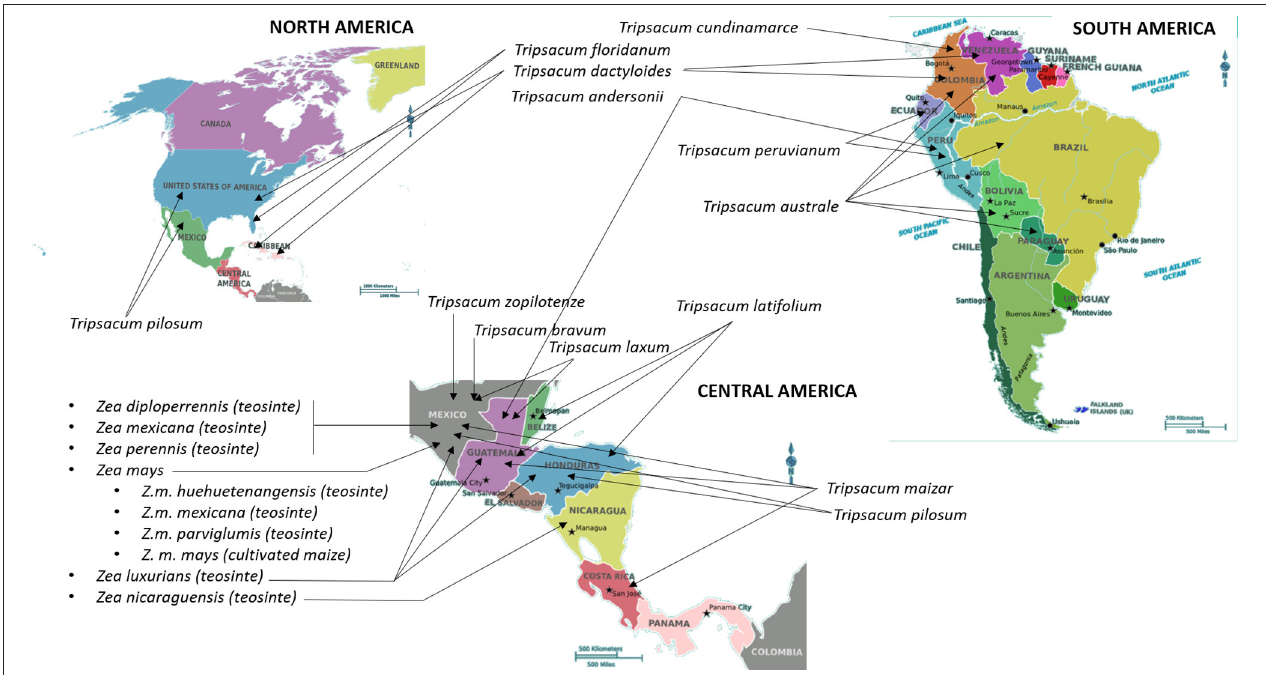
FIGURE 1 | Centers of origin and primary geographical distribution of cultivated maize and its wild relatives. Information on the distribution and centers of origin was gathered from Wilkes (1977), Doebley (1983), Iltis and Benz (2000), and Standley (2015). International Maize and Wheat Improvement Center (CIMMYT) (https://www. cimmyt.org/) is a major maize “living catalog of genetic diversity comprising over 28,000 unique seed collections of maize,” including teosinte species. In addition to CIMMYT, seeds of maize, teosinte, and Tripsacum species are stored and could be obtained from the Germplasm Resources Information Network in Beltsville, USA (https://npgsweb.ars-grin.gov/gringlobal/search.aspx) and N. I. Vavilov Research Institute of Plant Industry in Saint Petersburg, Russia